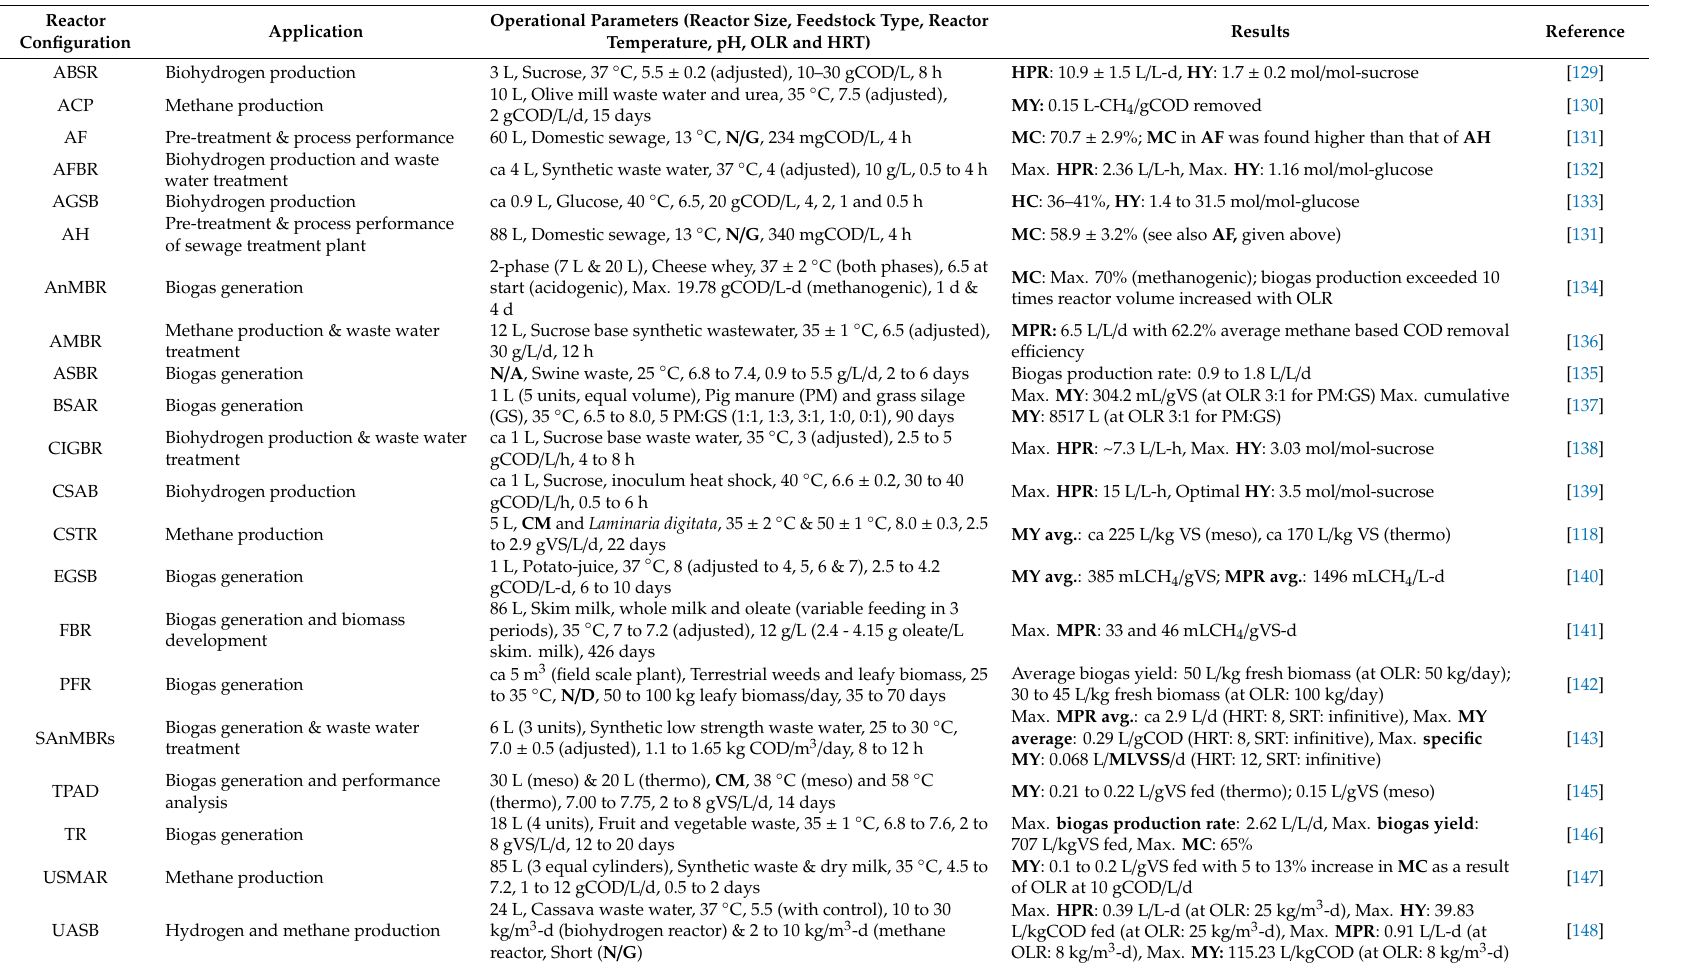
Table 4. Selected reactor configurations and their operating